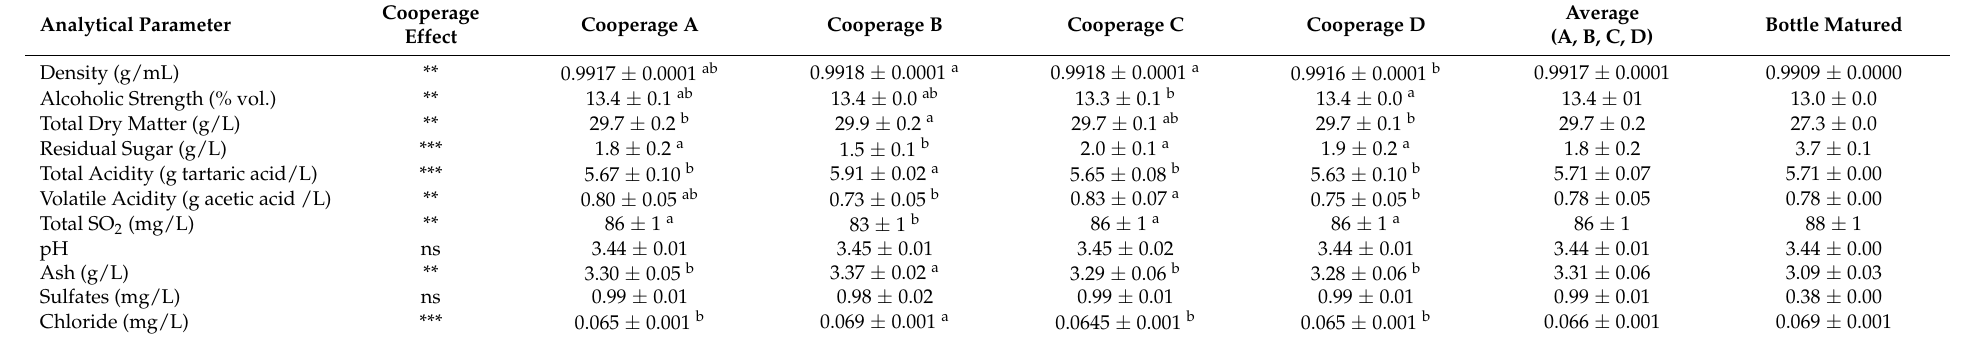
Table 1. General physical–chemical parameters of red wines after 12 months of aging in oak barrels by cooperage and of a bottle matured sample, and cooperage effect with statistical difference between the